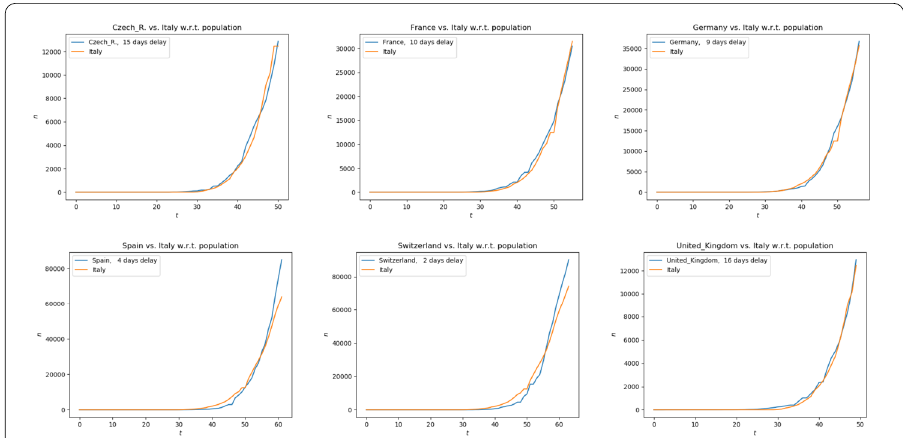
Figure 1 Number of confirmed Covid-19 cases in different European countries, scaled to the Italian population, as a function of time. Along each horizontal axis, time is measured in days starting January 22nd, 2020, each country compared to Italy being delayed by the amount indicated in each top left corner. The numbers of cases are taken from [2], the populations’ data from